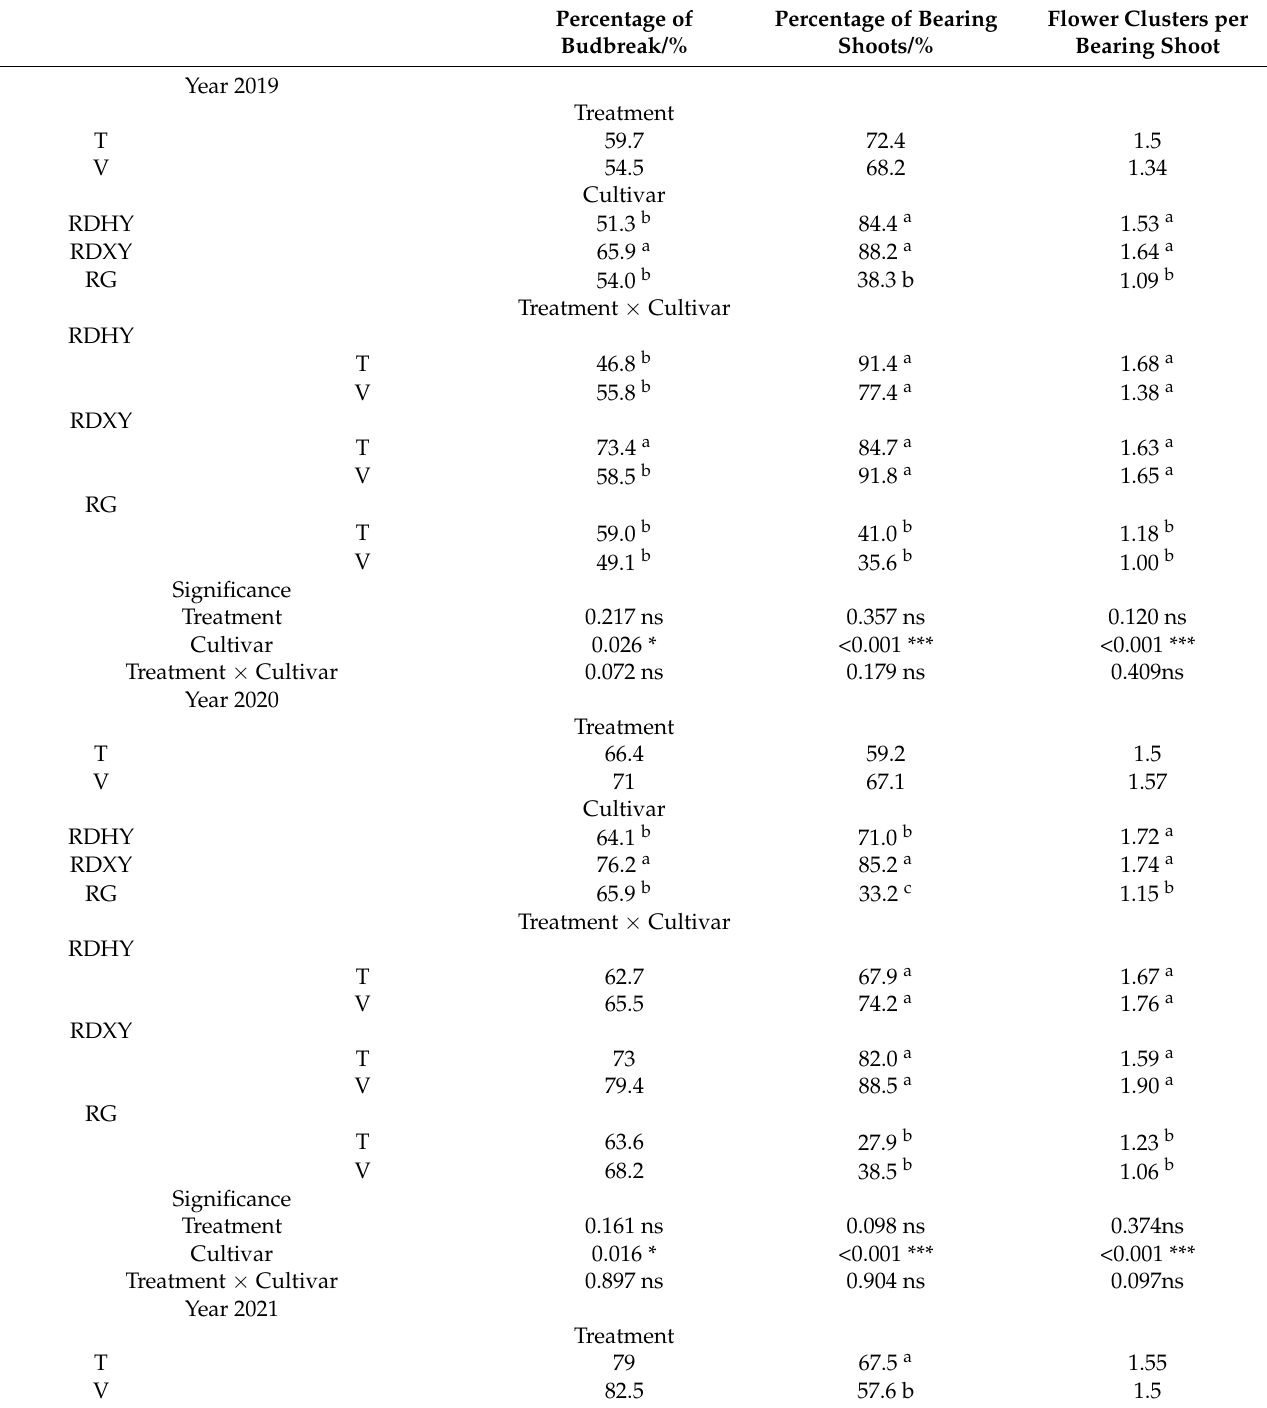
Table 1. Effects of trellis systems on the fruit load of three cultivars from 2019 to 2021. Data are the mean of three replications. A two-way analysis of variance (ANOVA) was conducted (treatment × cultivar). Within the same column and factor, different letters stand for the signifi- cant difference ( p value < 0.05) according to the Student–Newman–Keuls test. Significant differences are indicated: *, p value < 0.05; ***, p value < 0.001, ns, not